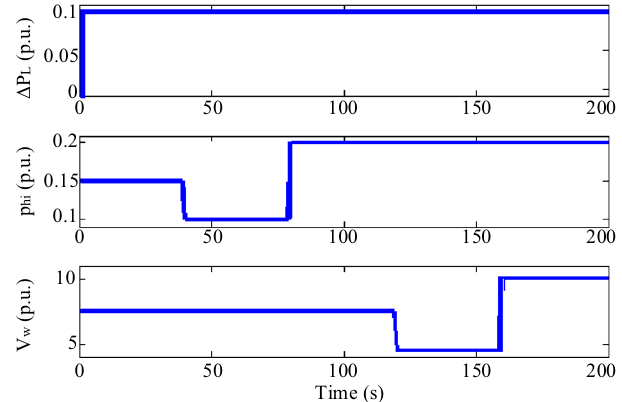
Figure 19. Scenario 4- Disturbances applied to solar irradiation, wind speed, and grid load.